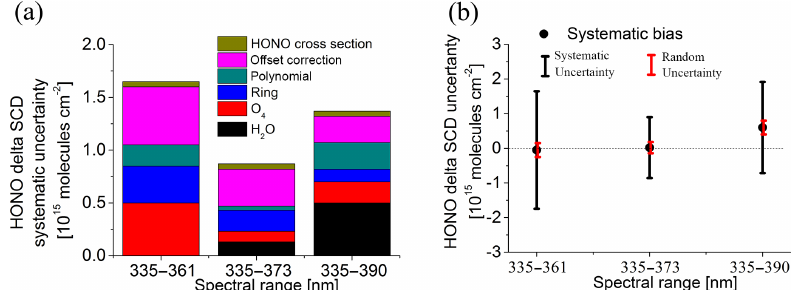
Figure 13. (a) Systematic uncertainties of the HONO delta SCDs with respect to different error sources for the three spectral ranges. (b) Systematic biases from the real values, of the retrieved HONO delta SCDs (black dots) derived from the synthetic spectra in the three spectral ranges; black and red bars indicate typical total systematic and random uncertainties (for a SNR of 3000) of the retrieved HONO delta